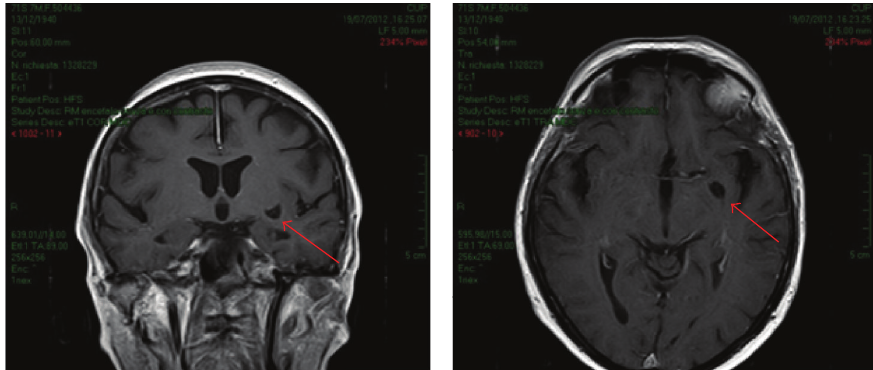
Figure 3: A large CSF perivascular space of the anterior perforated substance, in the basal portion of the left lentiform nucleus evidenced by a second MRI (indicated with arrows).